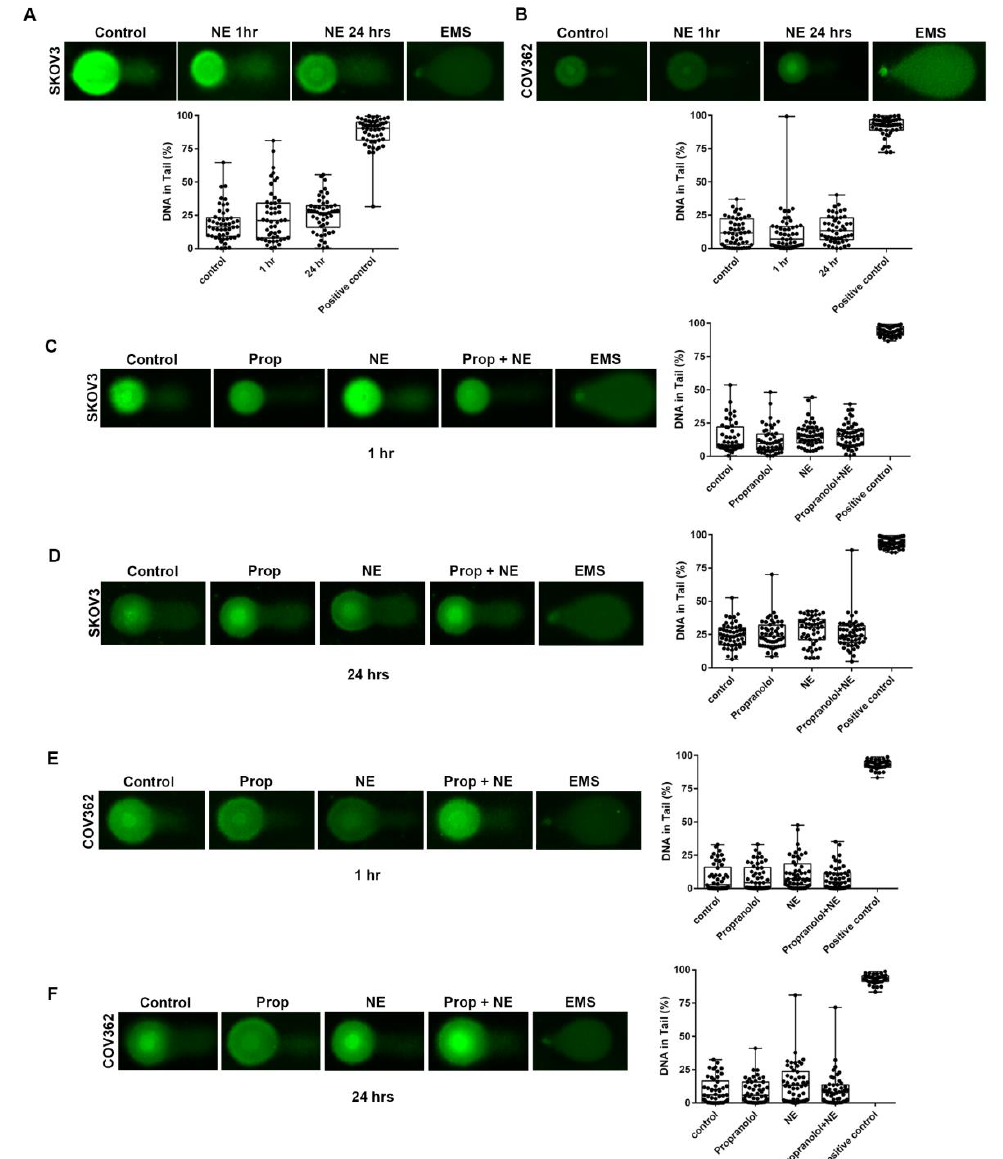
Figure 3. NE does not induce DNA single strand breaks in ovarian cancer cells. Alkaline comet assay after exposure NE (10 µM) in SKOV3 ( A ) and COV362 ( B ) cells after 1 h or 24 h. Alkaline comet assay after propranolol pre-treatment followed by NE exposure for 1 h or 24 h in SKOV3 ( C, D ) and COV362 cells ( E, F ). Single-strand breaks were measured using the percentage of DNA in tail. Fifty (50) comets were evaluated for each treatment. Data presented is representative of three independent experiments performed in duplicate. Statistical analysis was performed using one-way ANOVA with Dunn’s multiple comparison correction. No significant differences were observed among treatments ( p >